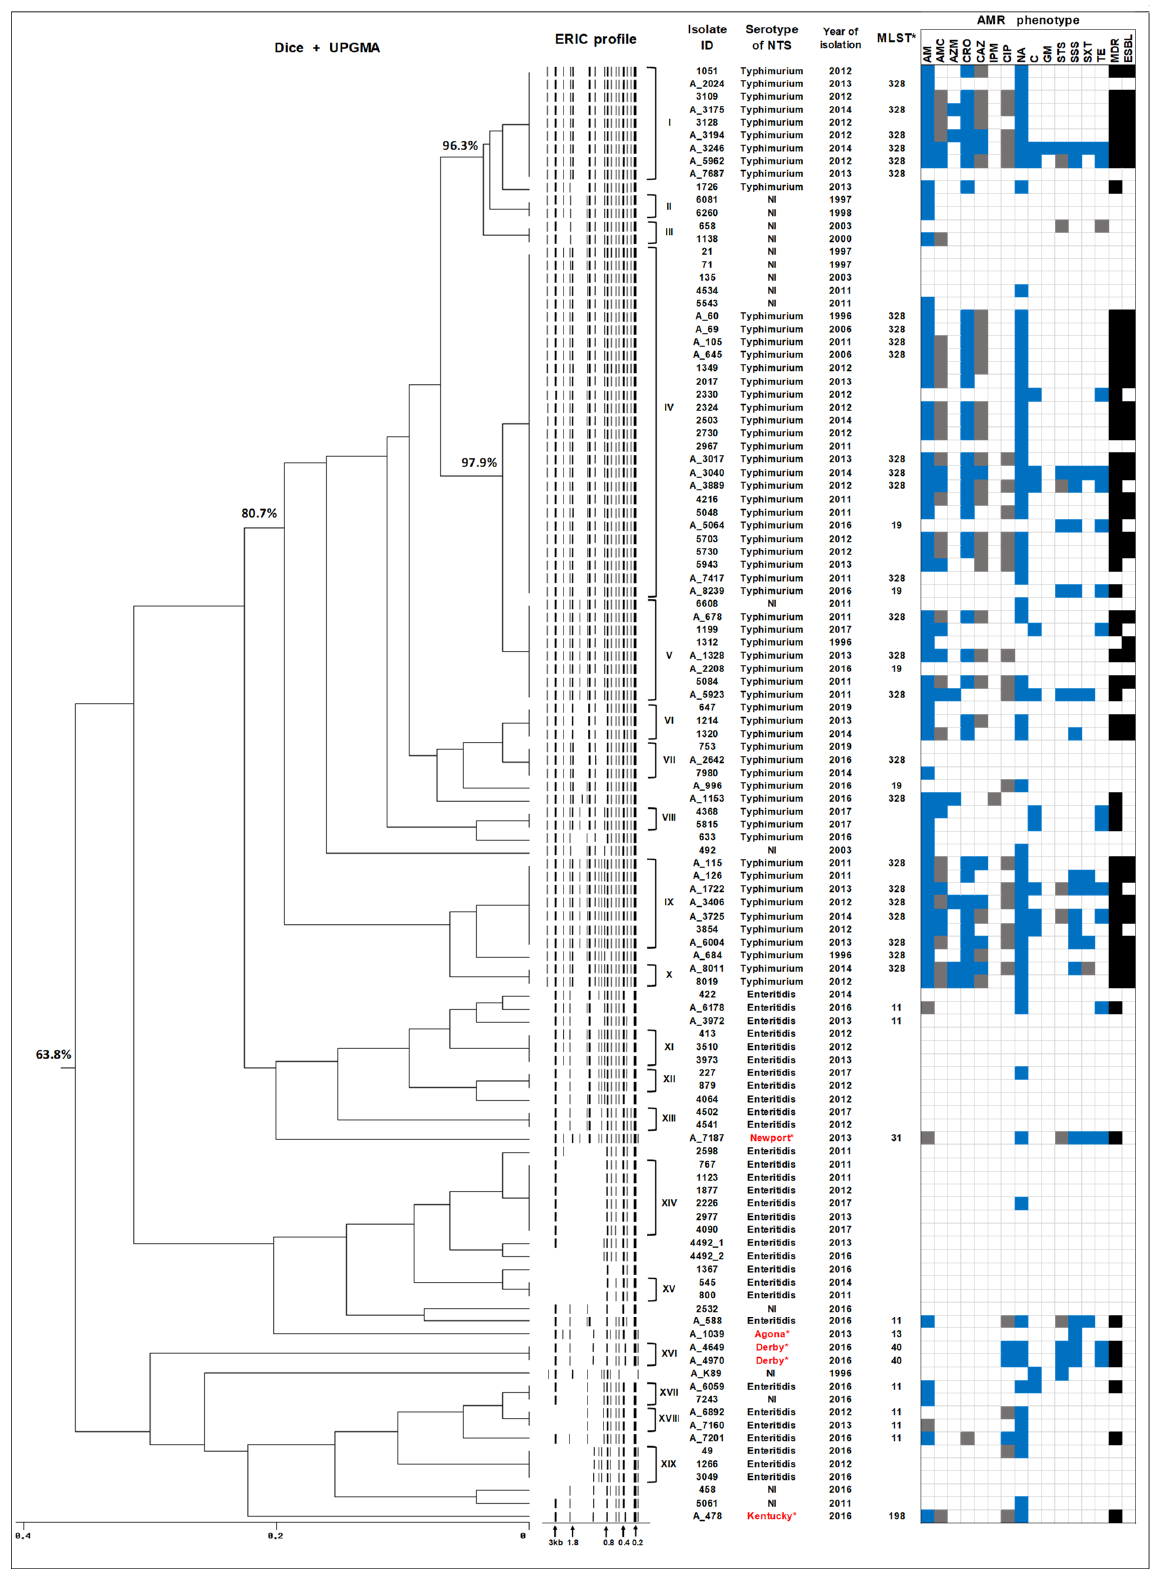
Figure 3. Dendrogram of ERIC-PCR fingerprinting profiles of 112 human NTS isolates from Armenia, with sequence types (MLST) and AMR phenotypes. The dendrogram was generated with Dice coefficient and the UPGMA clustering method. Colour keys: blue nodes represent resistant phenotype to